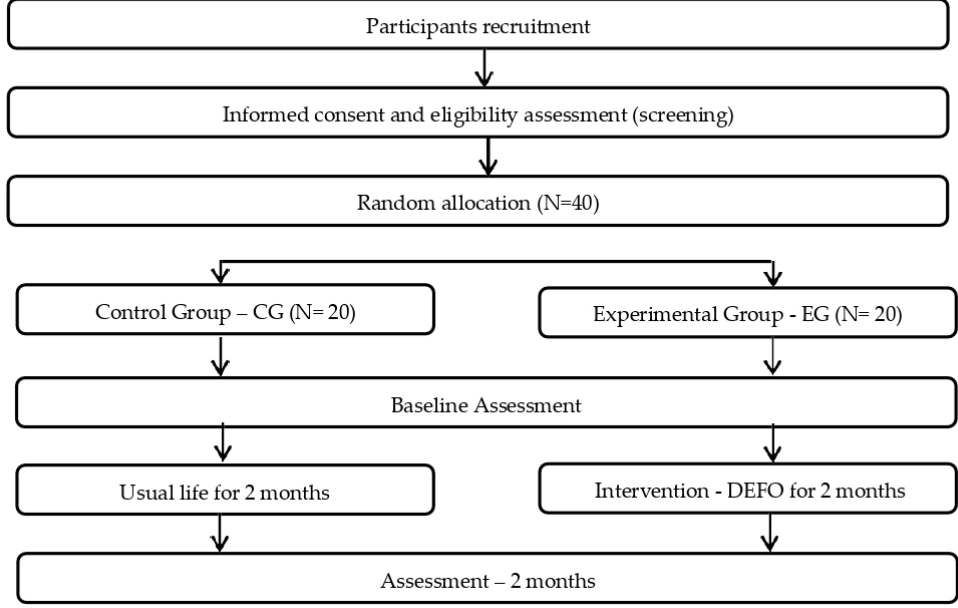
Figure 2. Study flow chart. DEFO: dynamic elastomeric fabric orthoses.